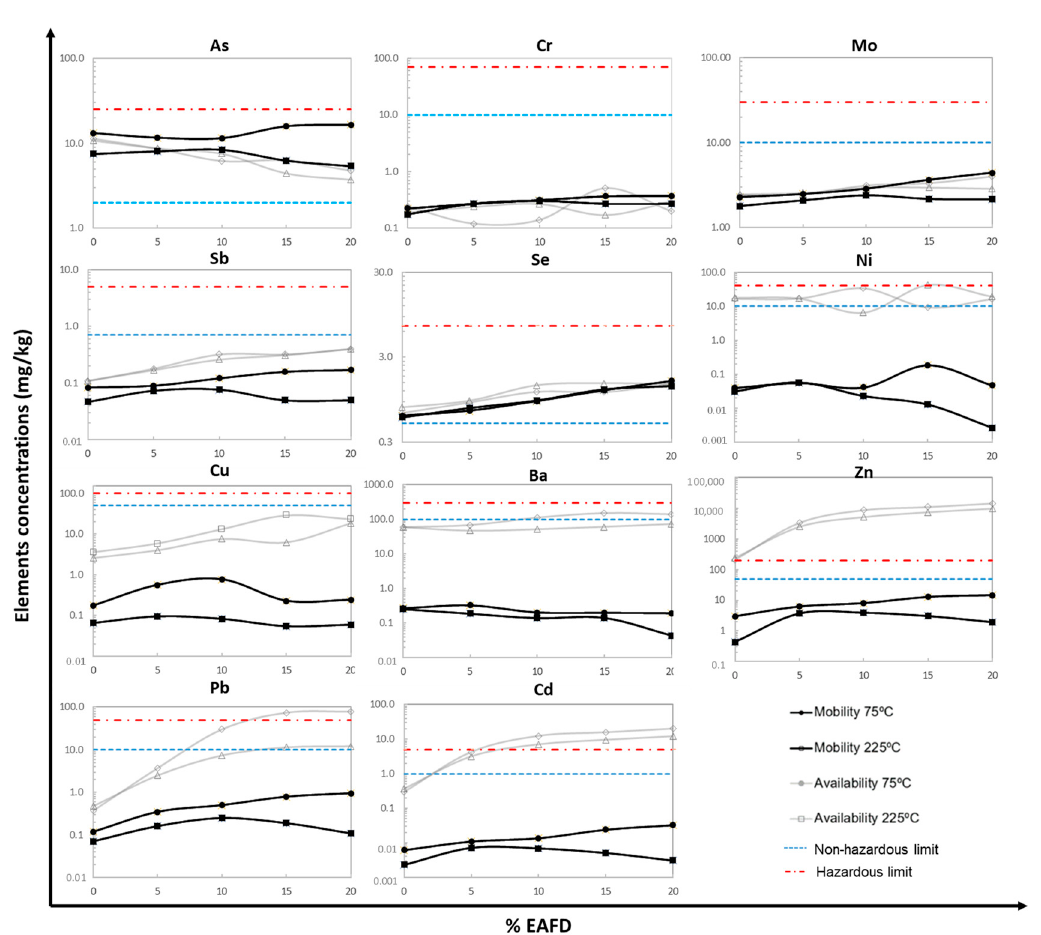
Figure 3. Concentrations (mg/kg) of contaminants in the leachate after the availability and equilibrium/compliance leaching tests of the geopolymers with EAFD at 75 °C and 225 °C.